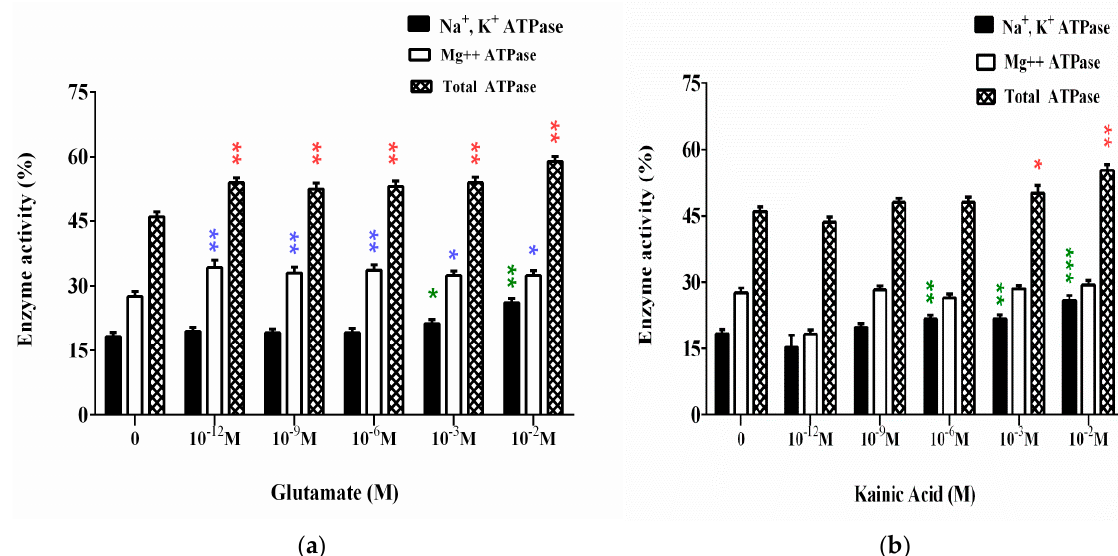
Figure 2. Effect of L-Glutamate ( a ) and kainic acid ( b ) at different concentrations on Na + , K + -ATPase (green color), Mg 2+ - ATPase (blue color) and total ATPas (red color) of synaptic membranes from the cerebral cortex. Here, 100% enzyme activity corresponds to: for Na + , K + -ATPase—18.3 µmol inorganic phosphate/mg protein/hour; for Mg 2+ -ATPase—27.6 µmol inorganic phosphate/mg protein/hour; for total ATPase—45.9 µmol inorganic phosphate/mg protein/hour. SE, as determined from four separate experiments, each assayed in triplicate (standard error of number of measurements n = 12 at * p < 0.05; ** p < 0.01; *** p < 0.001).